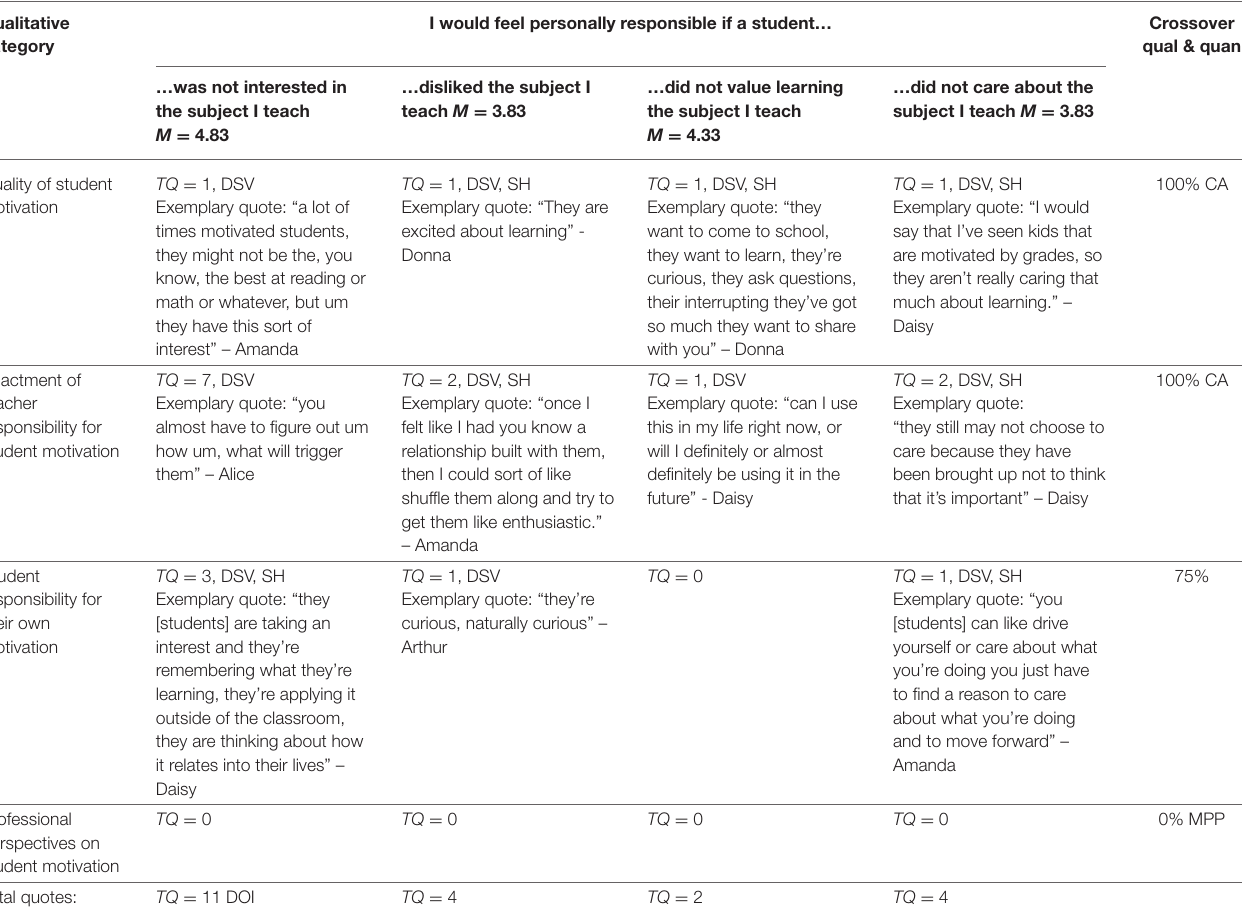
TABLE 4 | Joint display representing spaces of convergence and divergence between the qualitative and quantitative results ( n = 6). Qualitative